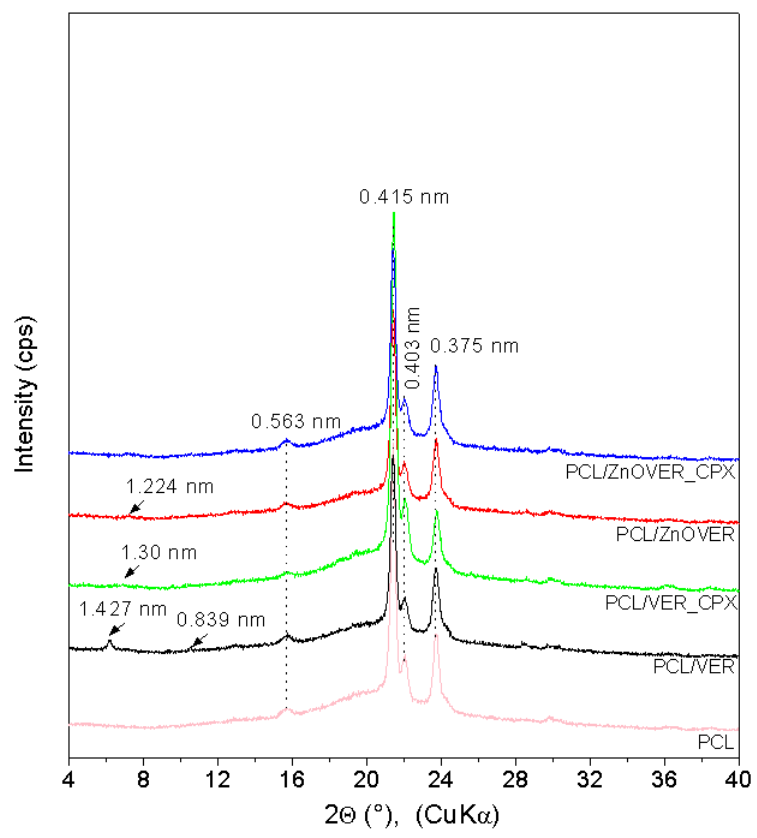
Figure 2. XRD patterns for pure PCL thin film and thin PCL/clay nanocomposite